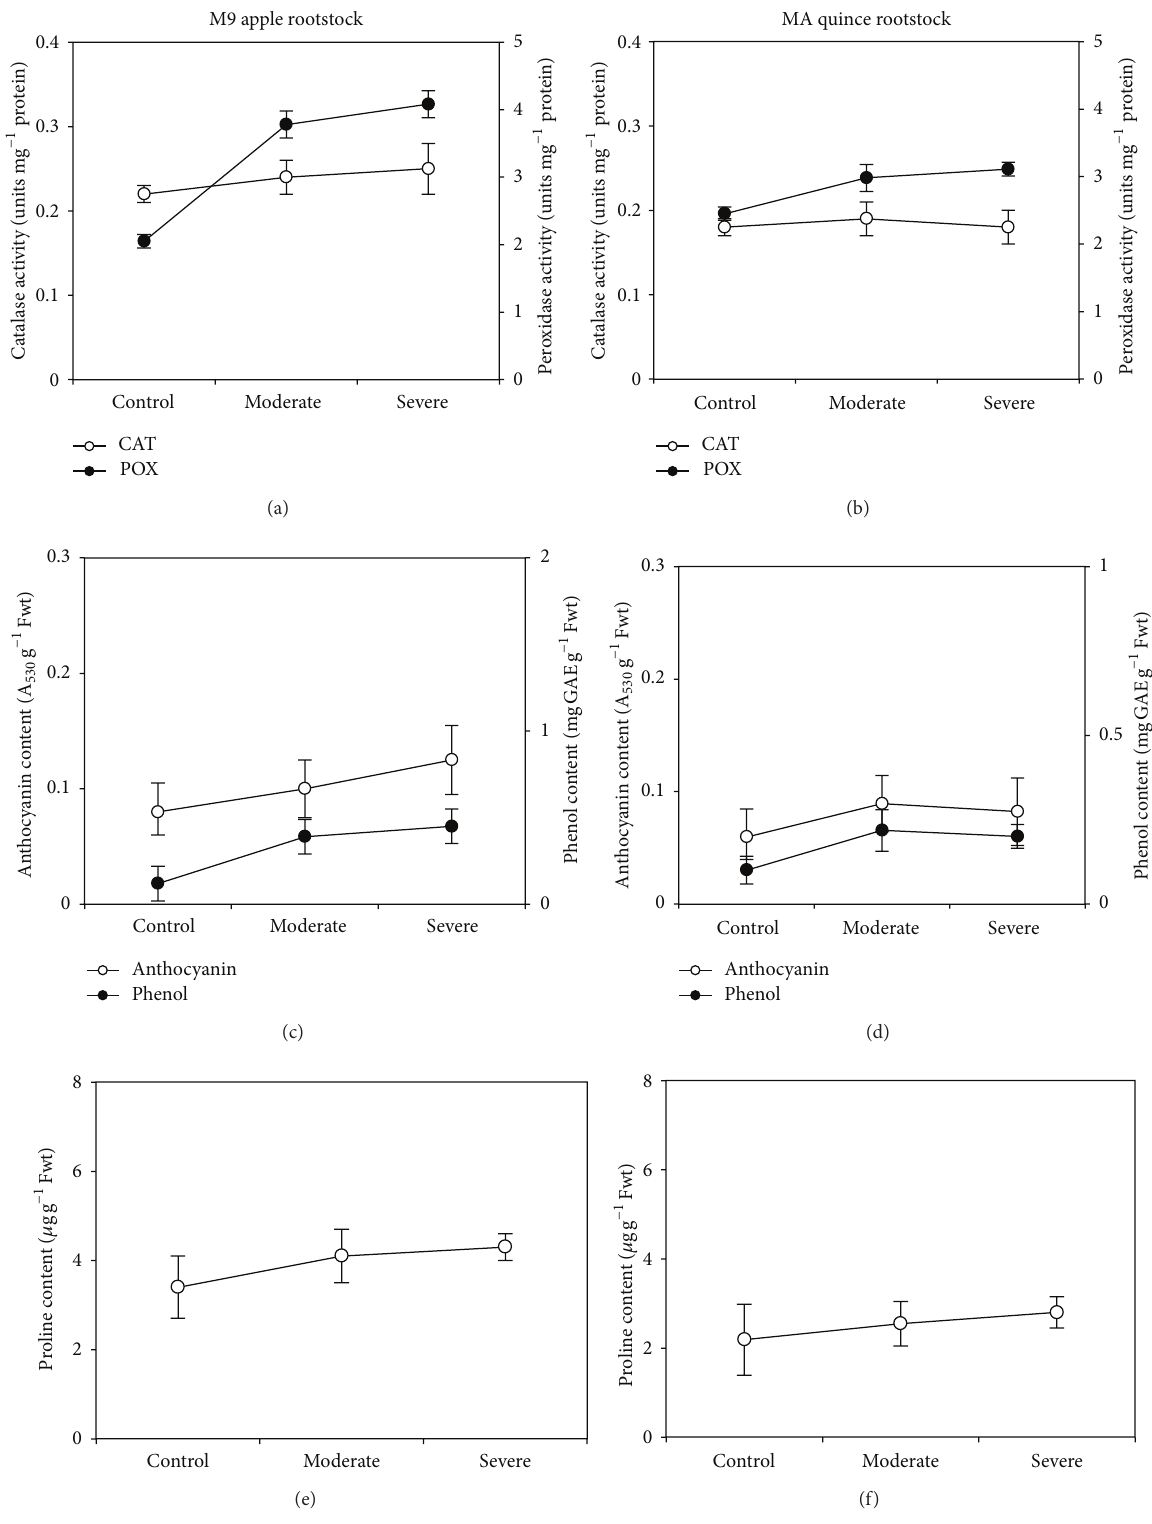
Figure 2: Biochemical parameters obtained from the rootstocks (M9 and MA) grown in various water stress levels. ((a)-(b)) Catalase and peroxidase enzymes; ((c)-(d)) anthocyanin and phenol; ((e)-(f)) proline contents in both rootstocks. (Vertical bars are standard deviation (SD) of